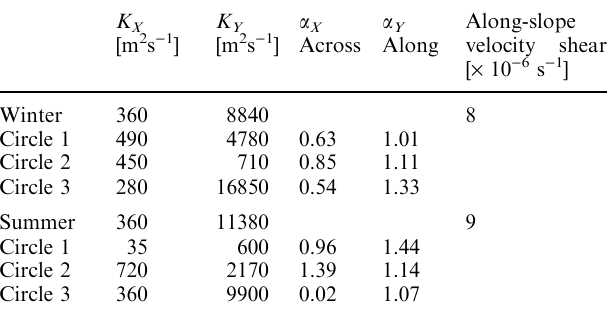
Table 3. Mean 100-day dispersion coe(cid:129)cients for the dispersing drifter circles. K and K are calculated from the rate of change in X Y the variance of across and along-slope position, X and Y . The regressed powers, a and a , are found from K X Y p = a and a (see Sect. 6.3.1). The mean values of all three circles X Y are given in the rows labelled winter and summer